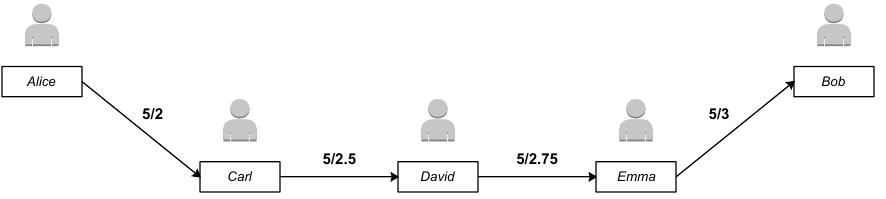
Figure 2. A demonstration of payment channel capacity. Alice sends 2 bitcoin to Bob through 3